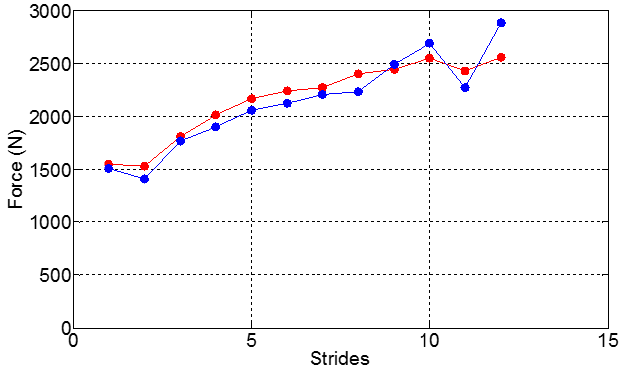
Figure 4. Measured (red) vertical GRF from force plates and predicted (blue) vertical GRF from IMU using accelerometer only. Sample data shown from participant two, right shank